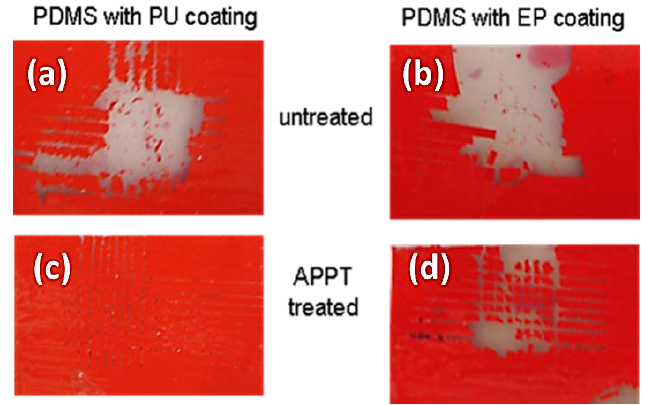
Figure 7. Cross-cut test on PDMS: ( a ) without APPT painted with PU, ( b ) without APPT painted with EP, ( c ) with APPT painted with PU, and ( d ) with APPT painted with EP.